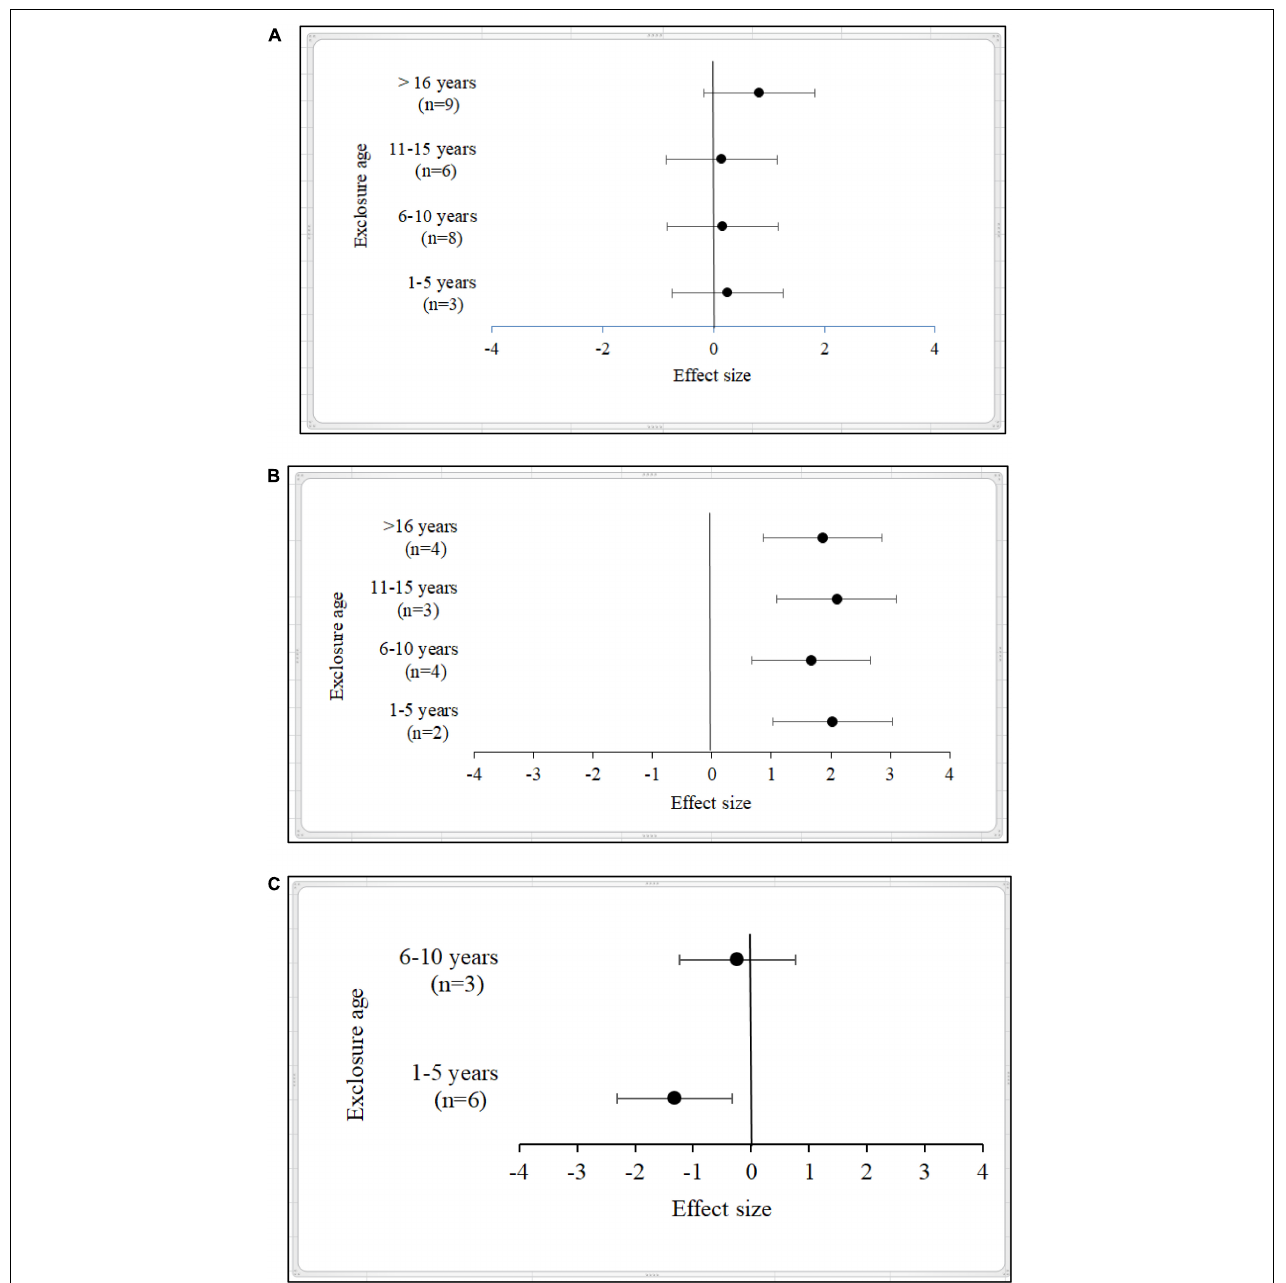
FIGURE 7 | Changes in total soil N after establishment of exclosures on communal grazing lands in Ethiopia: (A) Cambisols, (B) Luvisols, (C) Leptosols. See Figure 5 for further